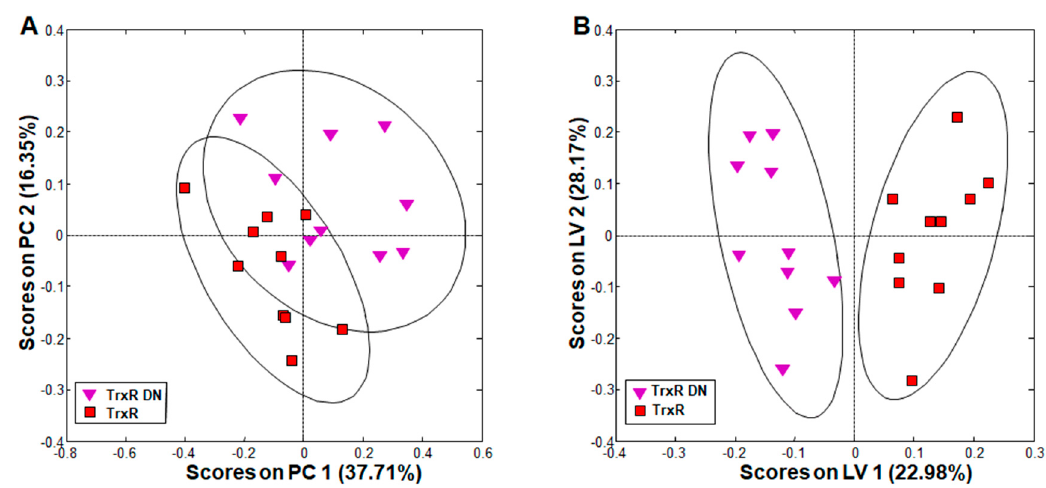
Figure 2. Principal component analysis (PCA) and orthogonal partial least squares discriminant analysis (oPLS-DA) of all integral regions (138 buckets) obtained by 1 H high-resolution magic angle spinning (HR-MAS) NMR analysis of TrxR and TrxR DN trophozoites. The ellipses show 83.4%